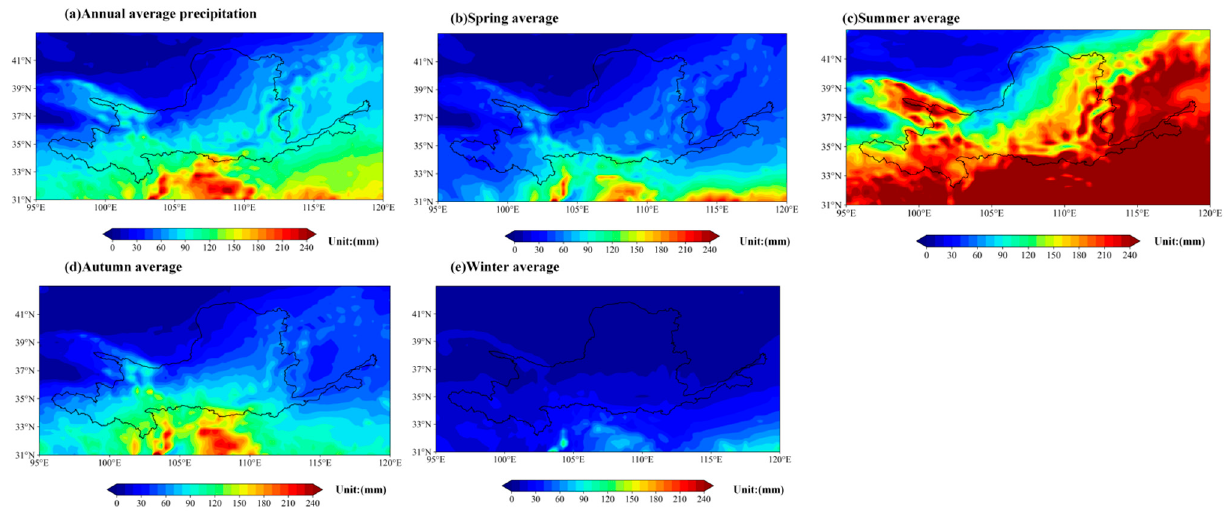
Figure 5. Annual average and seasonal average total precipitation of the Yellow River Basin from 1980 to 2019. (( a ): Annual average precipitation; ( b ): Spring average precipitation; ( c ): Summer average precipitation; ( d ): Autumn average precipitation; ( e ): Winter average precipitation).